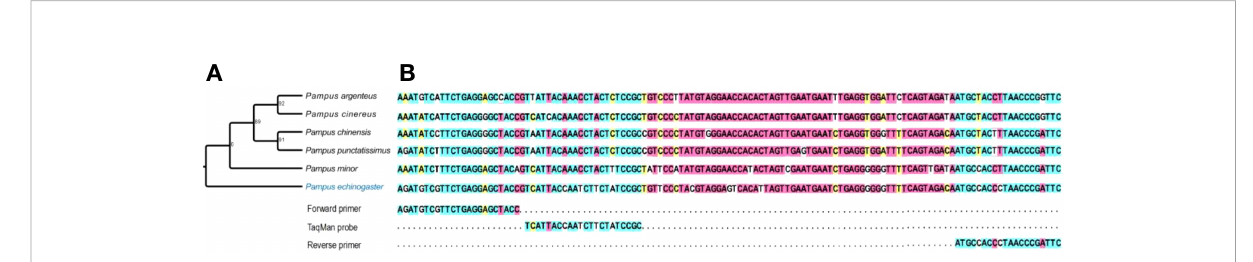
FIGURE 2 Phylogenetic tree of P. echinogaster based on Cyt-b sequences (A) and aligned with its closely related species (B)